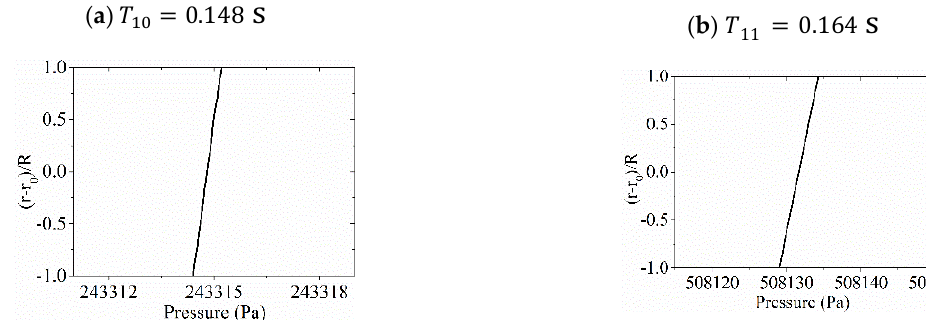
Figure 22. Axial velocity distribution at different time ( 𝑇 10 = 0.148 s and 𝑇 11 = 0.164 s ) of the S1 monitoring point.